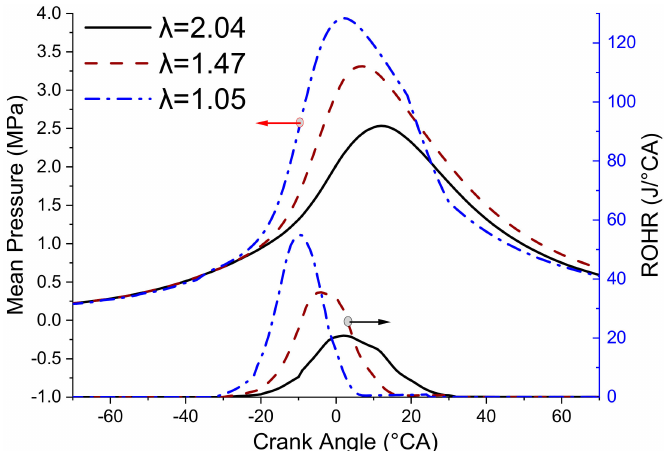
Figure 5. Di ff erent equivalent ratios of pressure and heat release